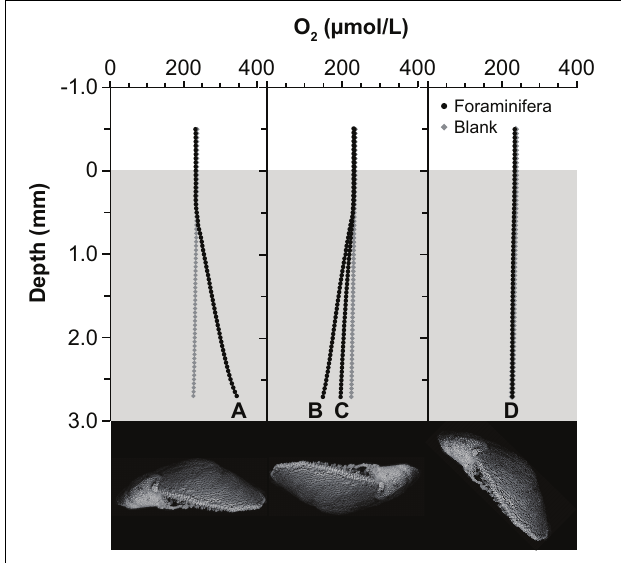
FIGURE 6 | Oxygen production and consumption of individual specimen. Oxygen profiles were measured from the edge of the capillary to the surface of the specimens. Each specimen was set inside a capillary tube (inner diameter, 0.36 mm; inner height, 3 mm) and measured along the (A) dorsal side, (B,C) ventral side, and (D) lateral side. Lower panel indicates lateral view of specimens indicating the position of the foraminiferal